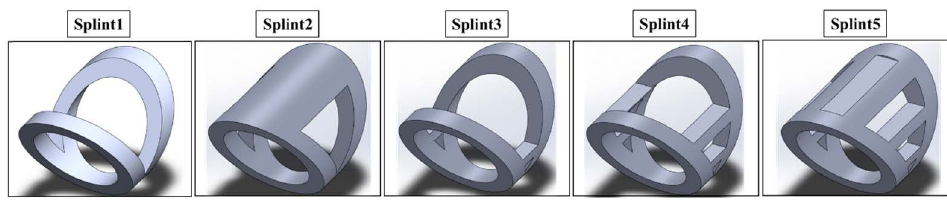
Figure 3. Different types of splint designs used for structural analysis .